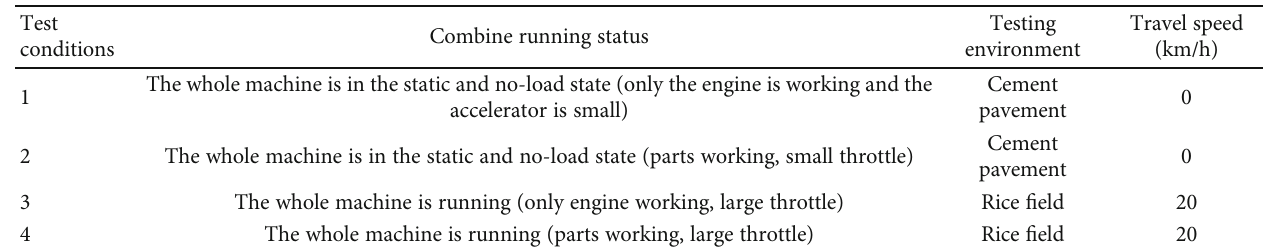
Table 2: Combine test